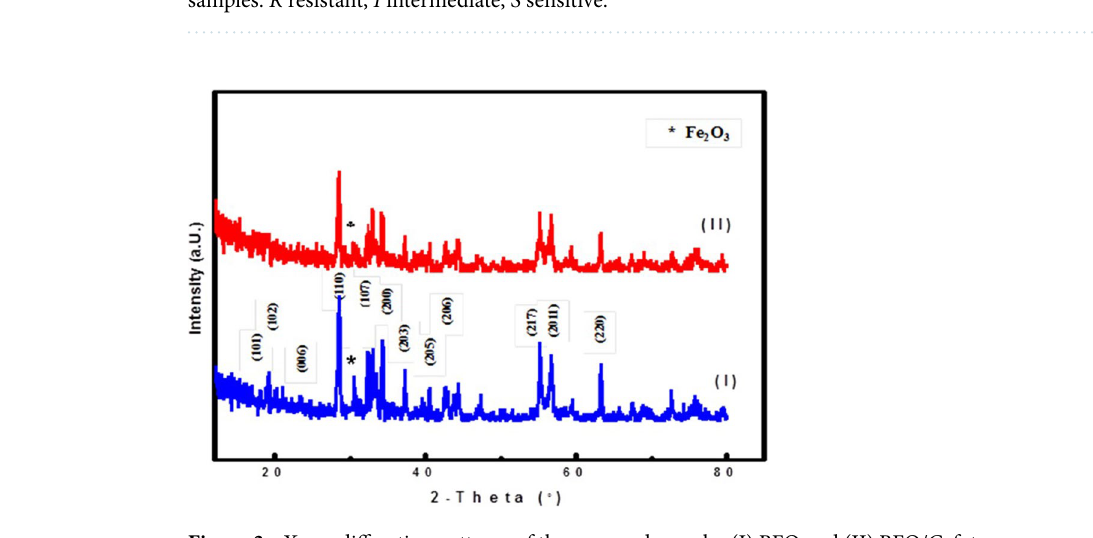
Figure 3. X-ray diffraction patterns of the prepared samples (I) BFO and (II)